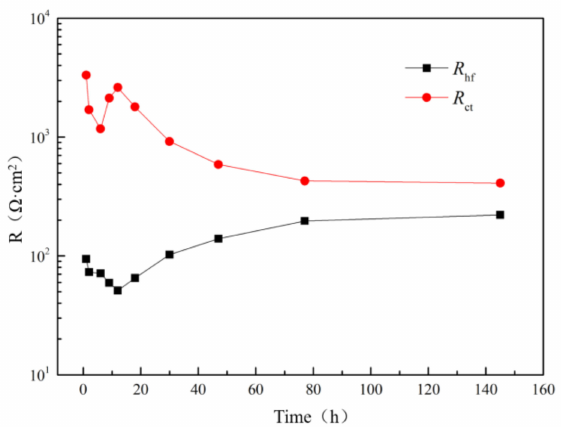
Figure 9. Fitted values of R hf and R ct of the Al–BN ACS in equivalent circuits.